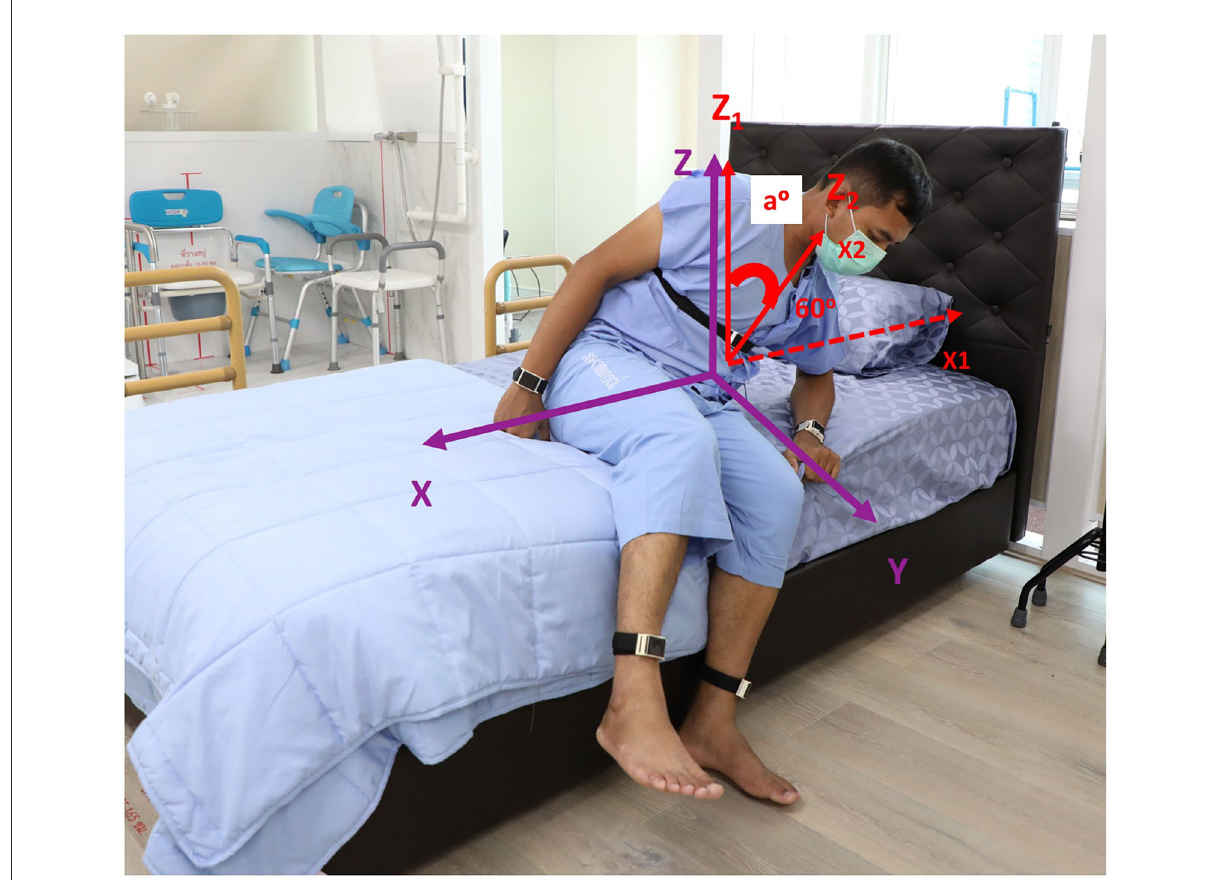
FIGURE3 An attempt to perform a supine-to-stand task in a control subject with superimposed three axes orientation of the sensor on the trunk (purple) and angle deviation (a ◦ ) as shown when a subject rose from the bed at 60 ◦ from the x -axis.